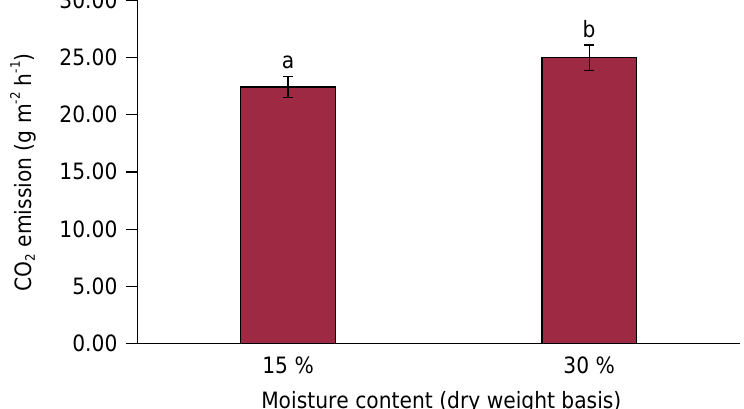
Figure 4. Accumulated emission of CO 2 of a calcareous soil with two moisture contents in the Comarca Lagunera, Mexico.